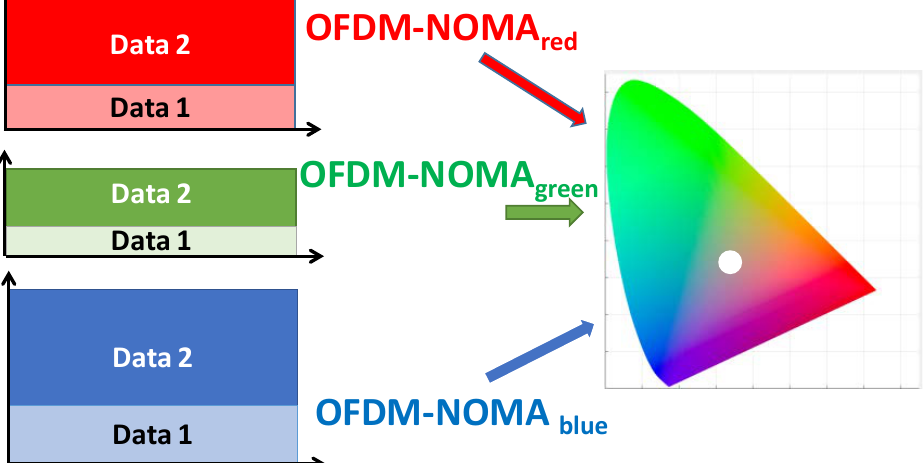
Figure 4. Concept of white light generation at the CIE 1931 chromaticity color gamut by the three color OFDM-NOMA channels.